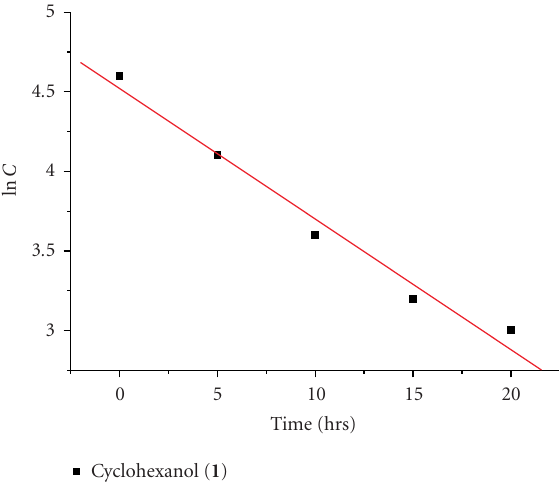
Figure 4: Photocatalytic oxidation of cyclopentanol 2 in acetoni- trile.